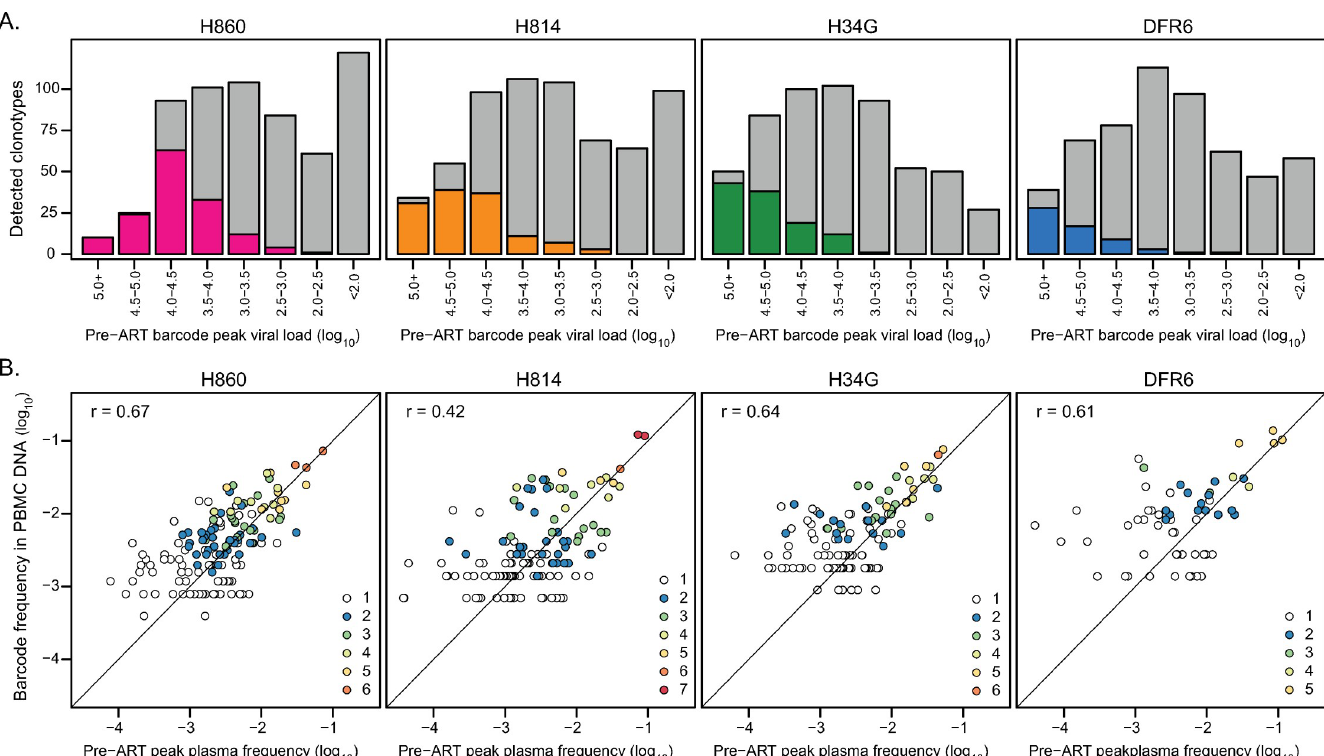
Fig 2. Barcode size in pre-therapy plasma is predictive of detection and relative abundance in PBMC CA-vDNA. (A) barcodes were partitioned into 0.5-log 10 intervals based on their pre-ART peak plasma SIV RNA viral loads. The grey bars depict the number of barcodes in each viral load category, and the colored bars highlight the number of lineages that were observed in CA-vDNA in at least one PBMC sample during suppressed viremia between 172 and 313 dpi. (B) The pre-ART plasma frequency attributable to each lineage is plotted against its estimated frequency in vDNA. The Pearson correlation between all lineages detected in at least two PBMC samples is indicated for each animal, with the linear regression line shown in black. The dashed grey line represents a theoretical one-to-one ratio of barcode proportions. The color of the points indicates the number of PBMC samples each barcode was detected in. The number of PBMC samples analyzed was 6 for H860, 8 for H814, 6 for H34G and 5 for DFR6. For H814, no single barcode was detected in all 8 samples.